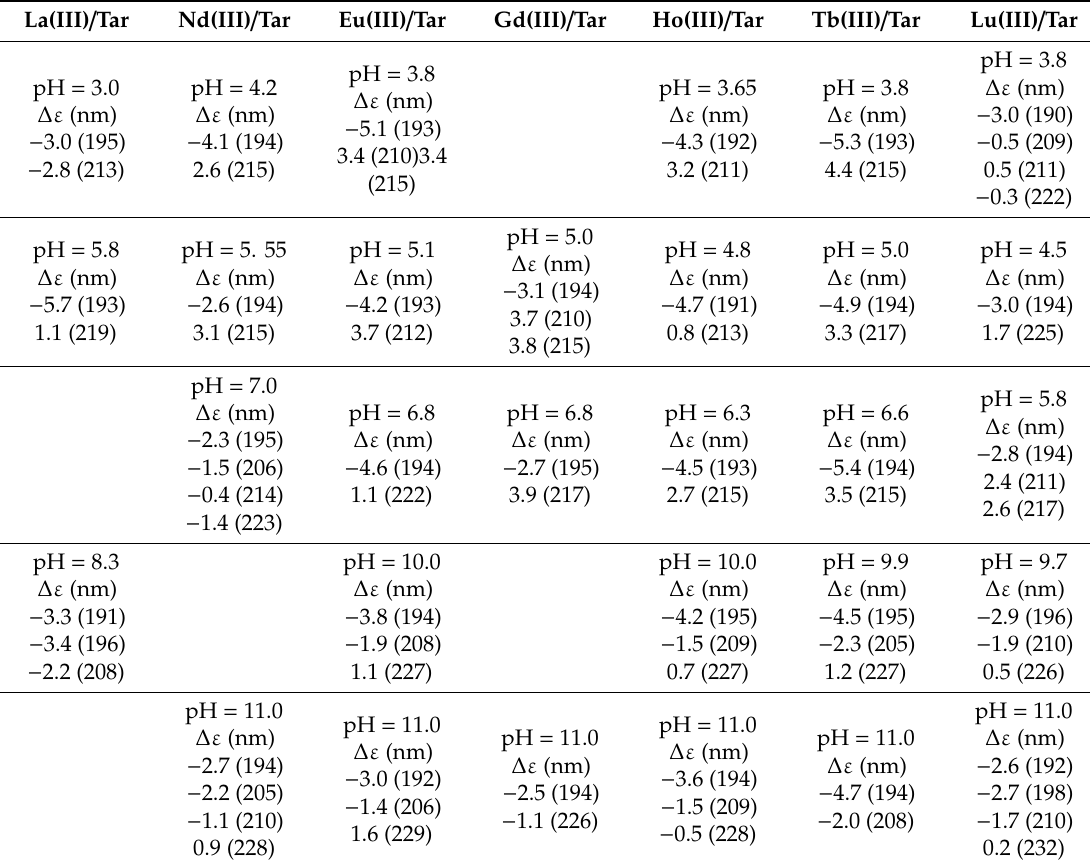
Table 5. ∆ ε values for all Ln(III) / Ta systems at di ff erent pH